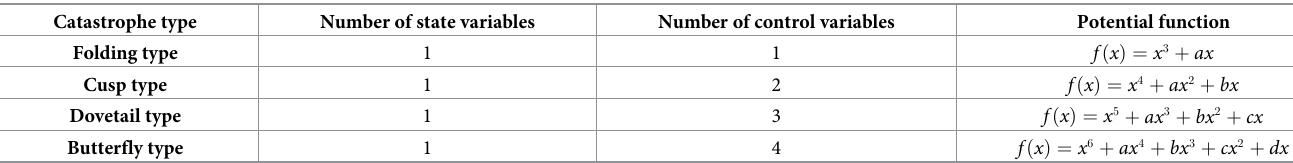
Table 2. Elementary catastrophe